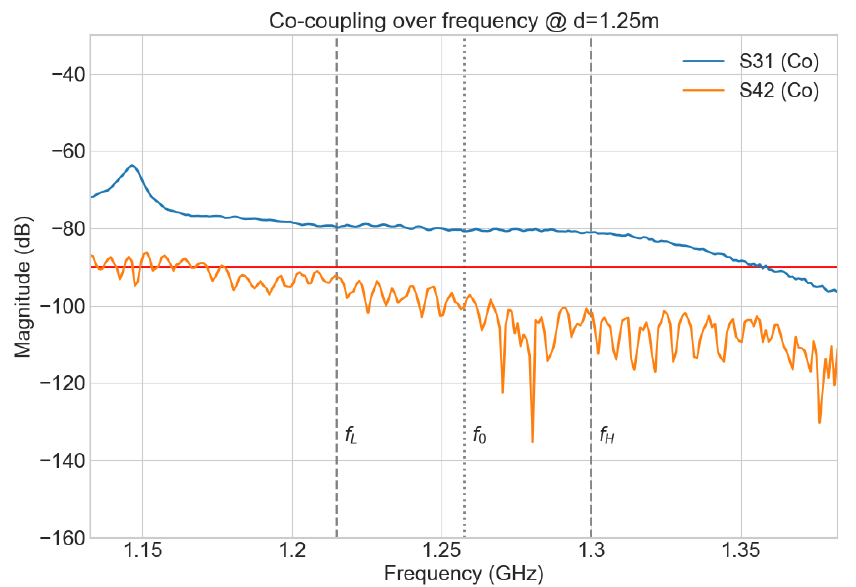
Figure 8. Measurement results for both co-coupling parameters S 31 and S 42 in dB at a distance of 1.25m between the antenna centers plotted against frequency. The relevant frequency range for the ROSE-L mission as well as the decoupling target are indicated in the